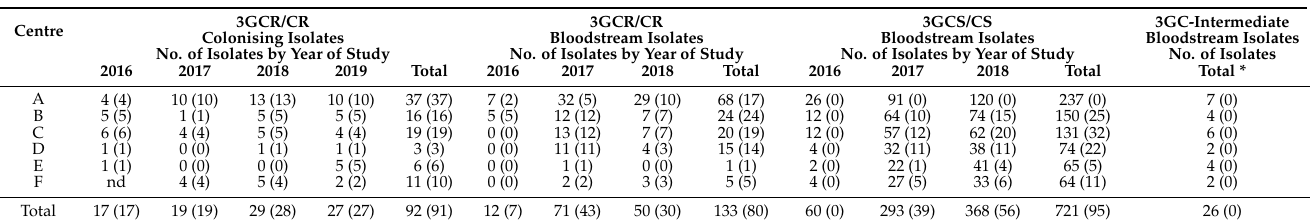
Table 1. Number of colonising and bloodstream K. pneumoniae complex isolates recovered at six study centres in Germany.